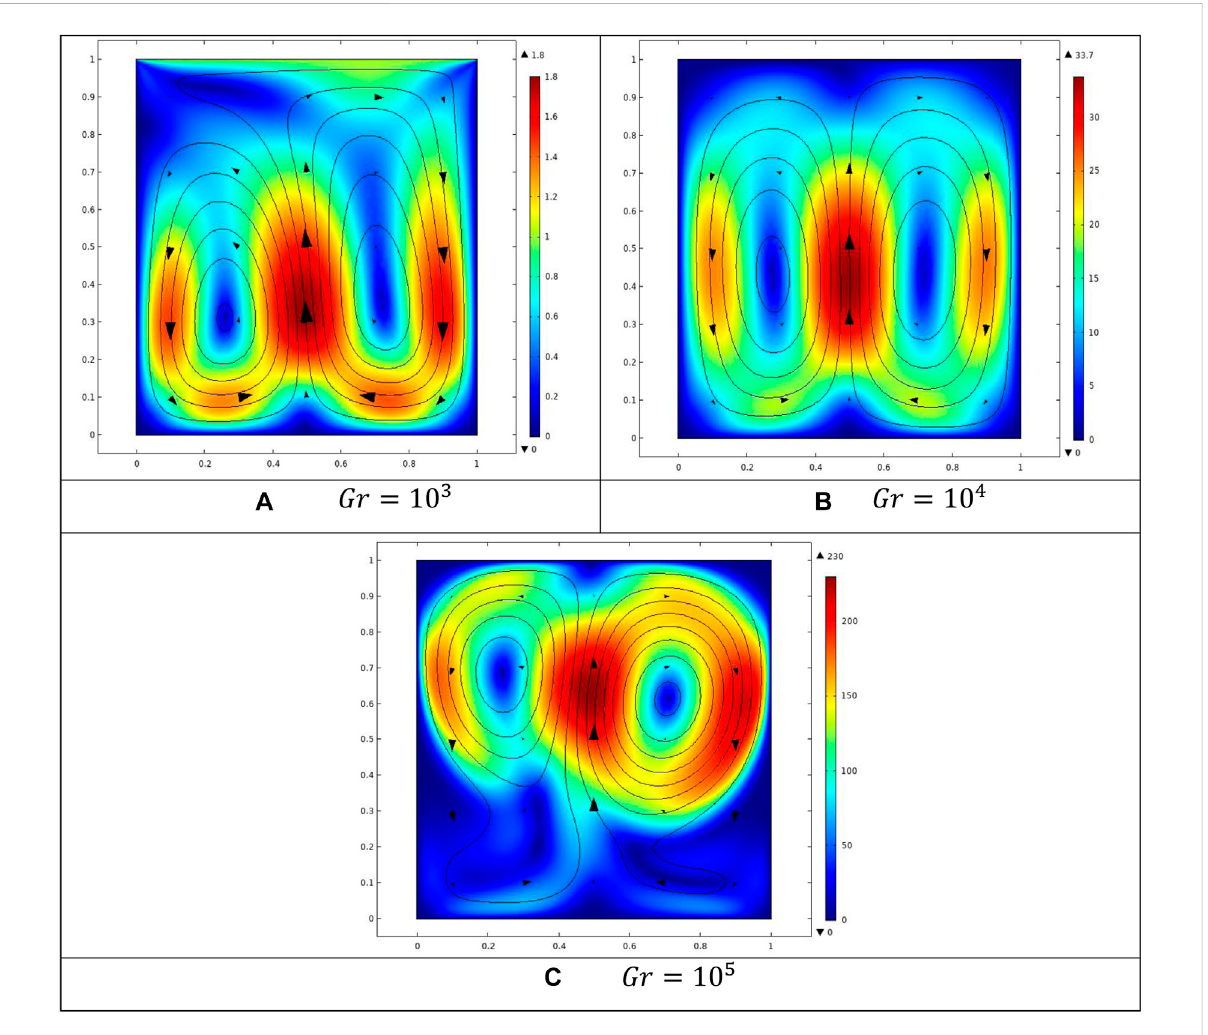
FIGURE 11 In fl uence of Gr on streamlines for the non-uniform heating case: (A) Gr (cid:1) 10 3 , (B) Gr (cid:1) 10 4 , and (C) Gr (cid:1) 10 5